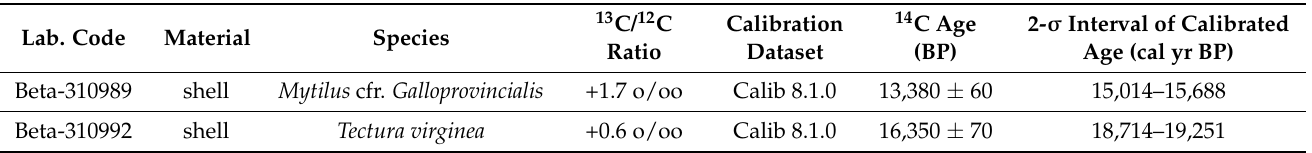
Figure 12. ( a ) Morphobatimetric DTM shadow relief showing the depression that hosted the palaeo-lagoon in the LGM; the arrow shows dredging (DR3); ( b ) sampled thanatocenosis. Bivalvia: (1) Mytilus cfr. Edulis , (2) Mytilus cfr. Galloprovincialis , (3) Glycymeris sp., (4) Parvicardium exiguum , (5) Pitar cfr. Rudis , (6) Venus cfr. Casina ; Gasteropoda: (7) Tectura virginea (L ó pez Correa et al., 2010 [70] for the distribution of the Tectura virginea species). ( c , c 1 ) Ascending two-cylinder experimental dredger; the arrow indicates part of the dark grey sandy silt deposit; ( d ) enlarged image of Tectura virginea . Table 1. Radiocarbon dating results. The 14 C data were calibrated using an online version of Calib 8.1.0 (http://calib.org) and a standard marine reservoir age Bastia, Corse